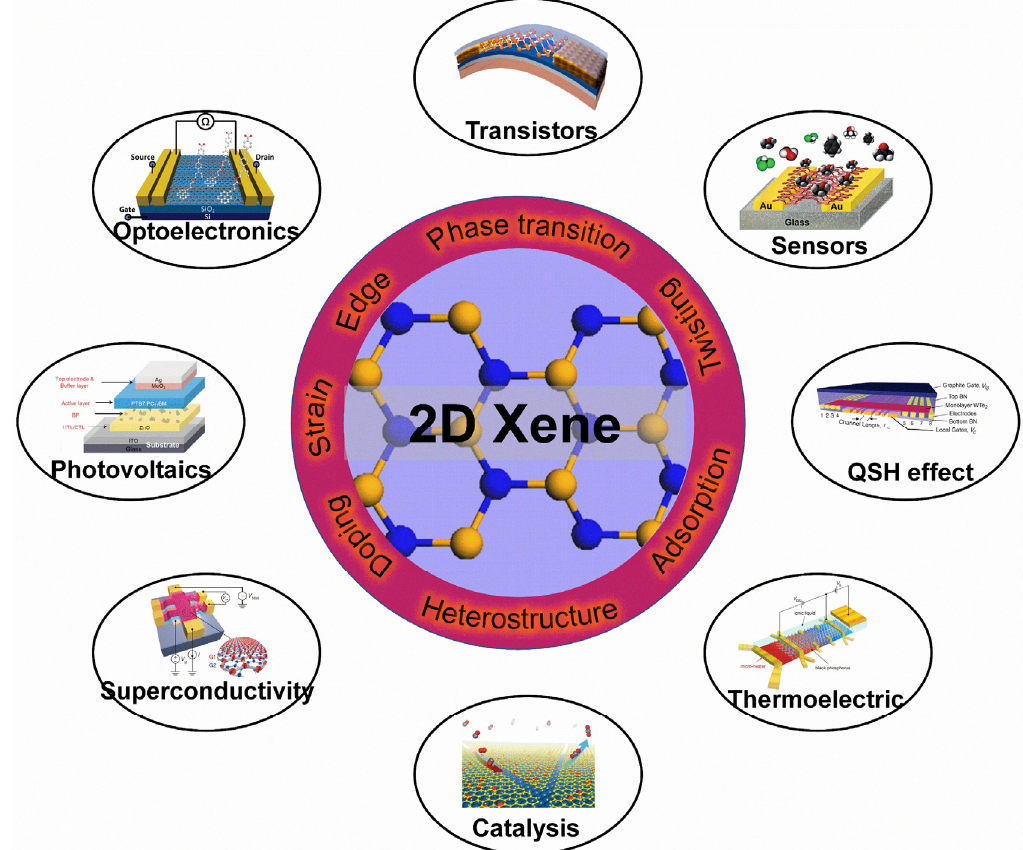
Figure 12. Applications of 2D Xenes with surface modifications. Transistors: Reprinted with per-